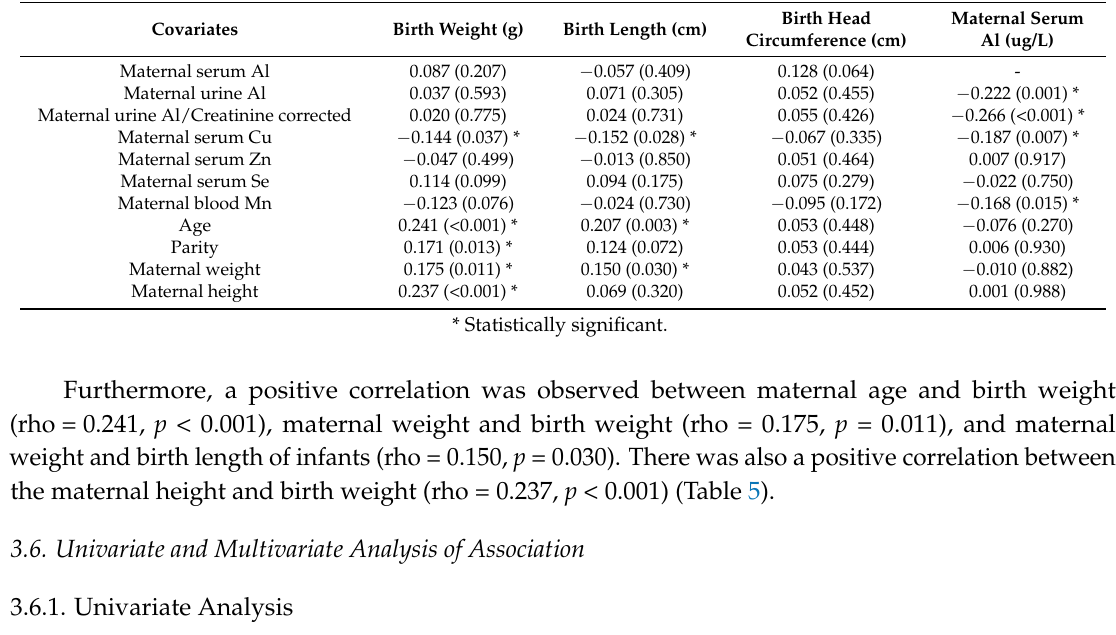
Table 5. Spearman’s rank correlation coefficient ( p -value) of association between maternal serum Al, the status of selected essential elements, maternal covariates, and infant